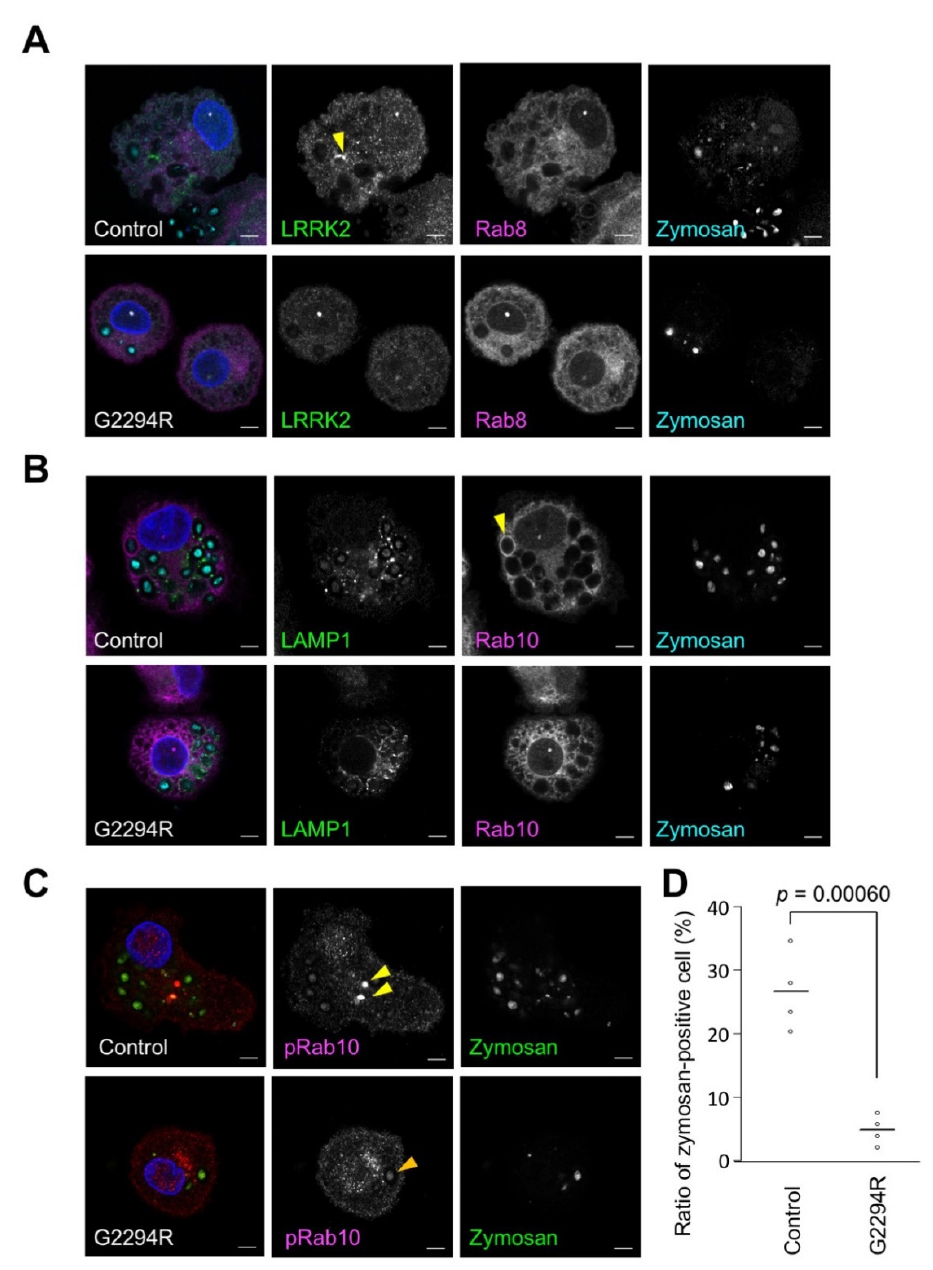
Figure 3. Phagocytosis is impaired by the p.G2294R variant. ( A – C ) Macrophages differentiated from monocytes were treated with zymosan conjugated with pHrodo Green for 2 h. The subcellular localization of the indicated endogenous proteins and nuclei (blue) was visualized with specific antibodies and DAPI, respectively. The scale bars are 5 µ m. The yellow arrowheads in ( A , B ) indicate LRRK2 and Rab10 accumulated on phagosome membranes, respectively. ( C ) The yellow arrowheads in the control cells indicate phosphorylated Rab10 strongly accumulated at the zymosan, and the orange arrowhead in p.G2294R cells shows phosphorylated Rab10 weakly accumulated at the zymosan. ( D ) The graph shows the ratio of zymosan-positive cells, which was decreased by p.G2294R mutation. The data (bars represent the mean, n ≥ 52) are from four biological replicates; Student’s t